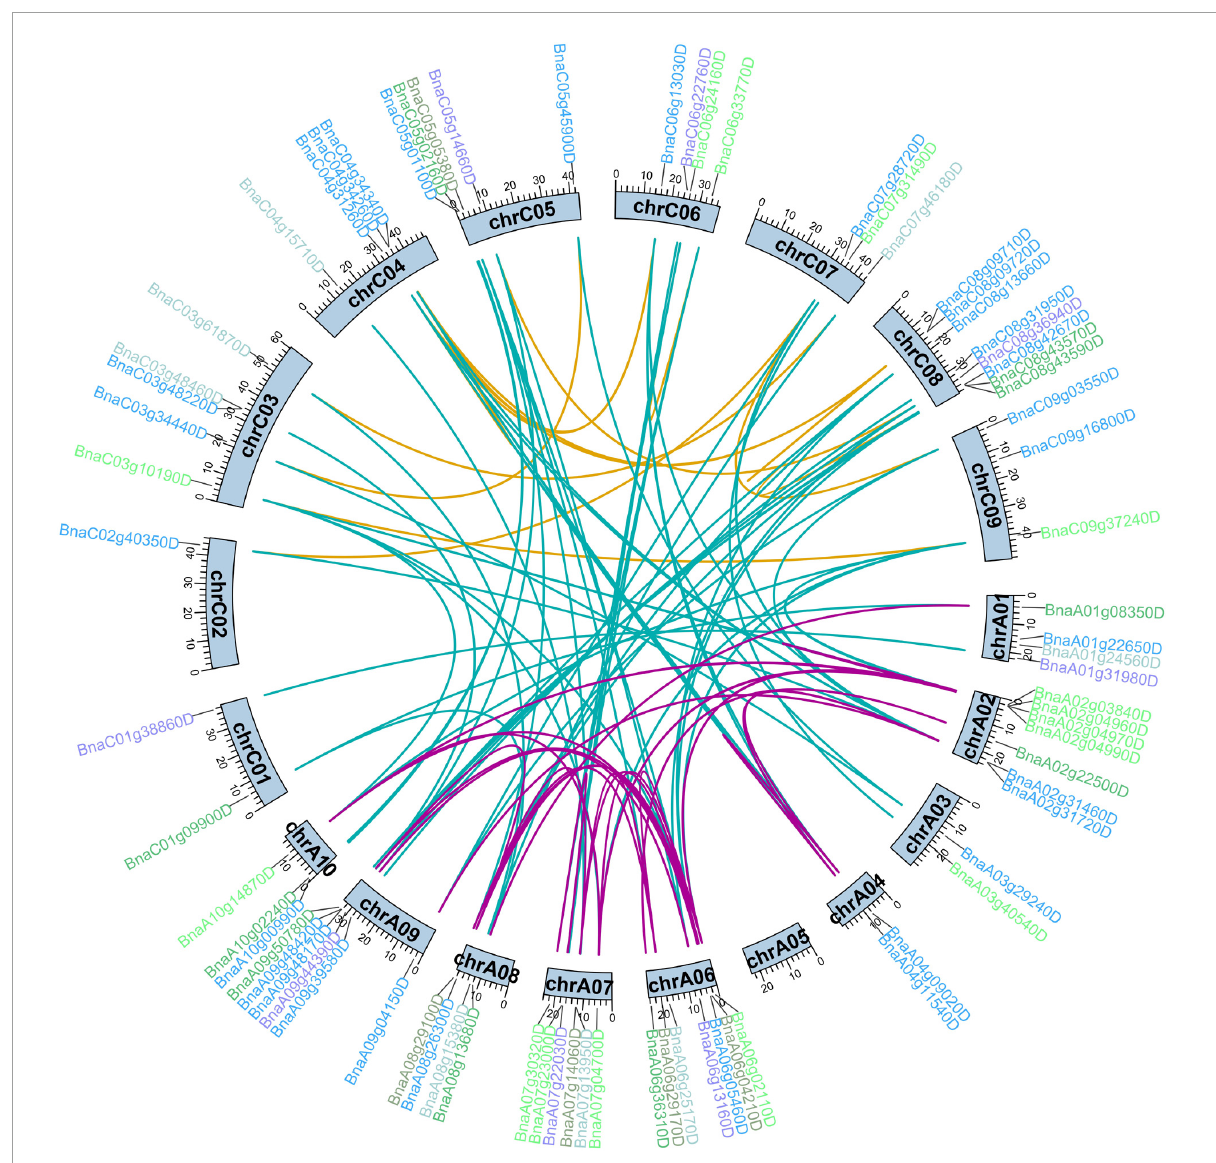
FIGURE2 Duplication analysis of BnCDP genes in Brassica napus . The gene names are marked outward of the corresponding chromosomes. The different colors indicate different subfamilies of the BnCDP genes. The duplicated gene pairs are highlighted with connecting lines colored according to the subgenomes, purple indicates that both genes in the gene pair are from the A n subgenome, yellow represents that both genes in the gene pair are from the C n subgenome, while the blue shows that two genes in the gene pair come from different